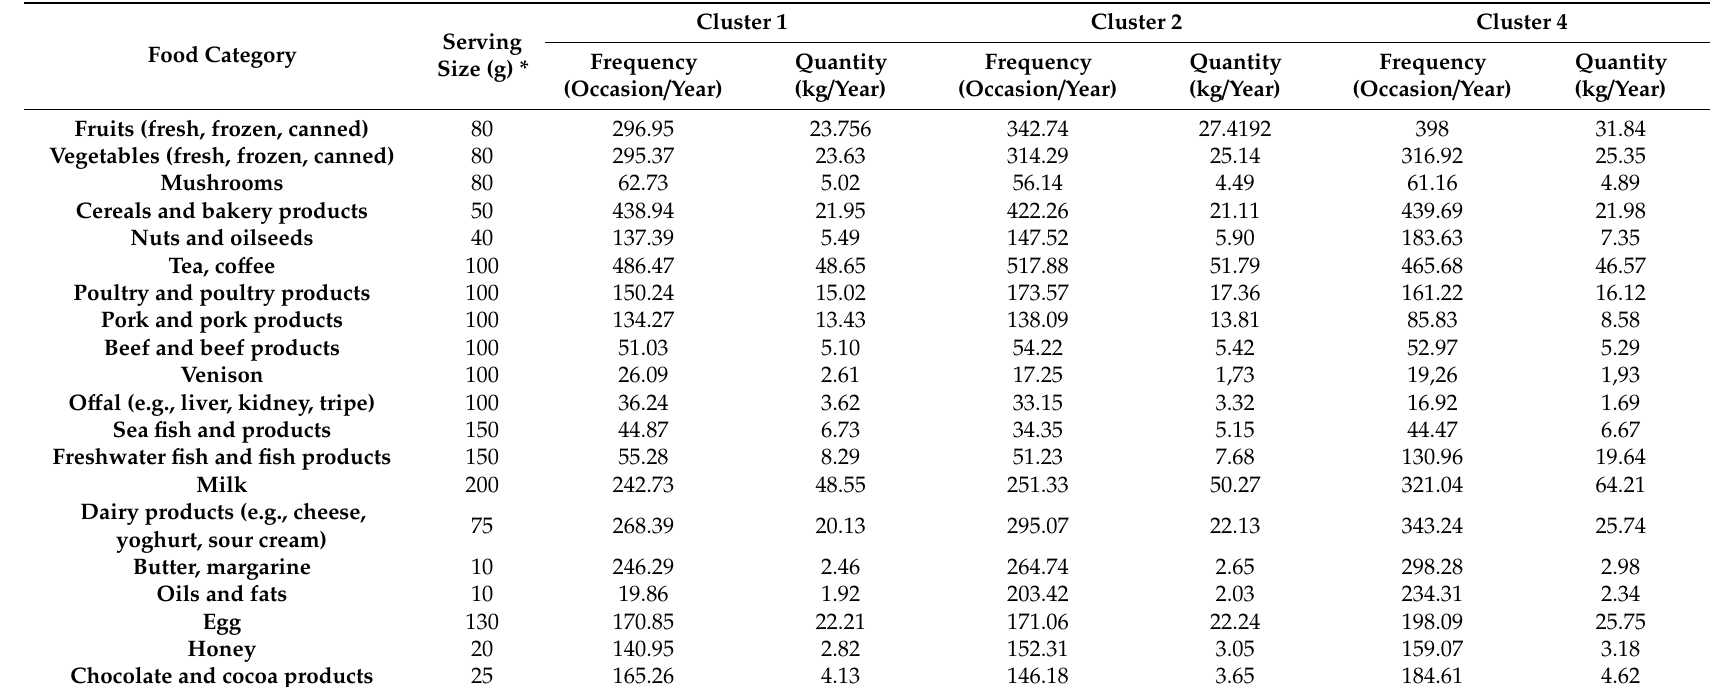
Table 5. The consumption patterns and DDT contamination of the food